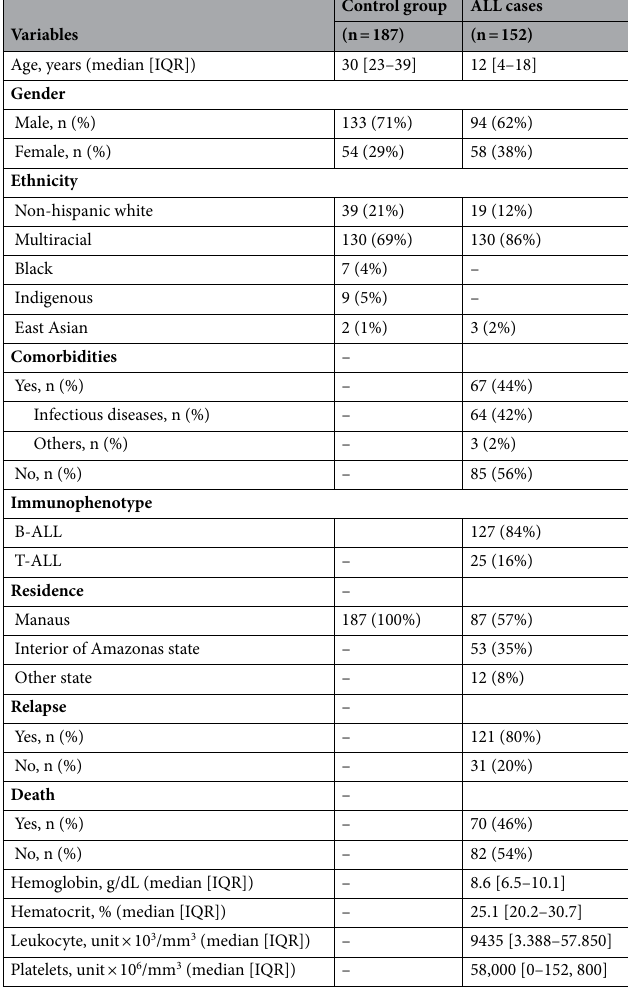
Table 1. Epidemiological and clinical characteristics of the study